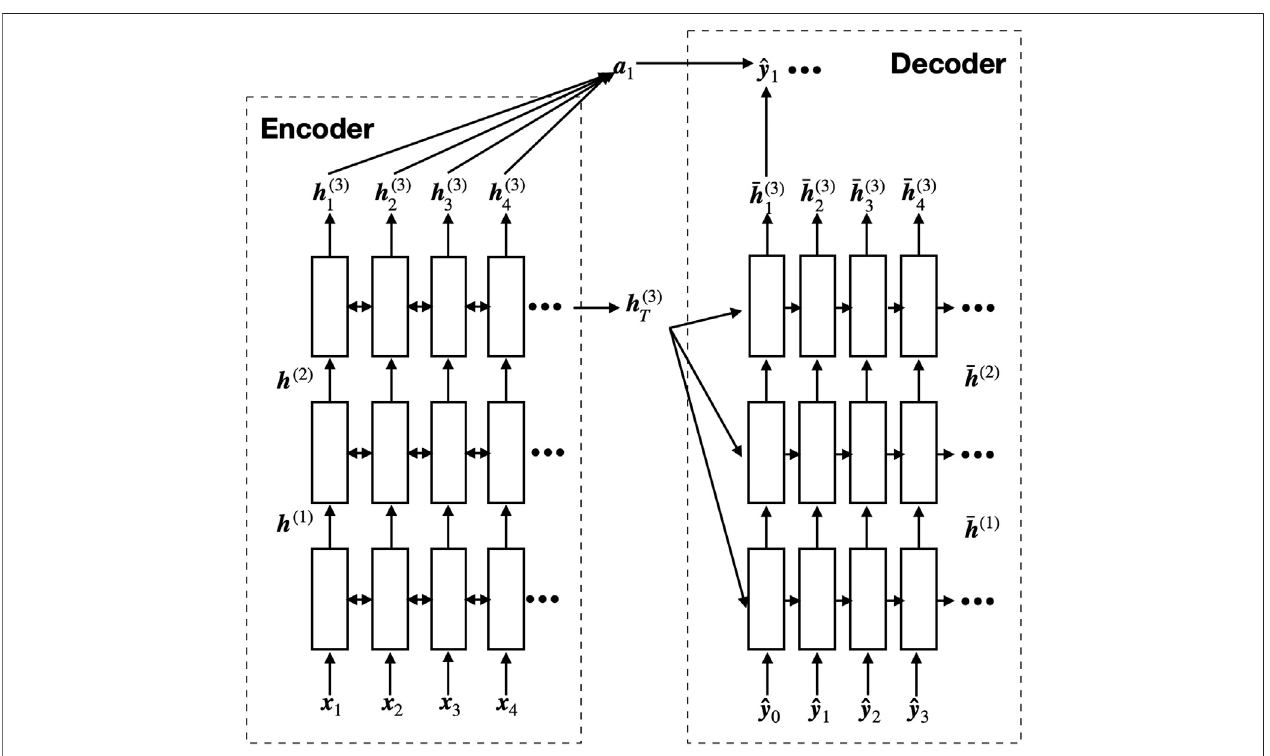
FIGURE1| Modelstructure ofa3-layerseq2seqmodelwithattention.The i th layertakestheoutputofthepreviouslayer( h ( i − 1 ) )asitsinput. a isthecontextvector, which can be calculated using different attention